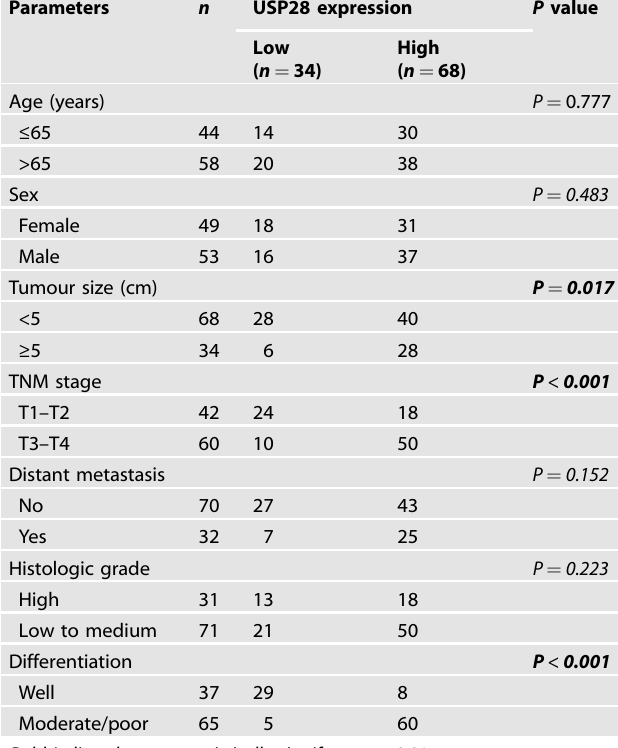
Bold Italic values are statistically signifcant, p